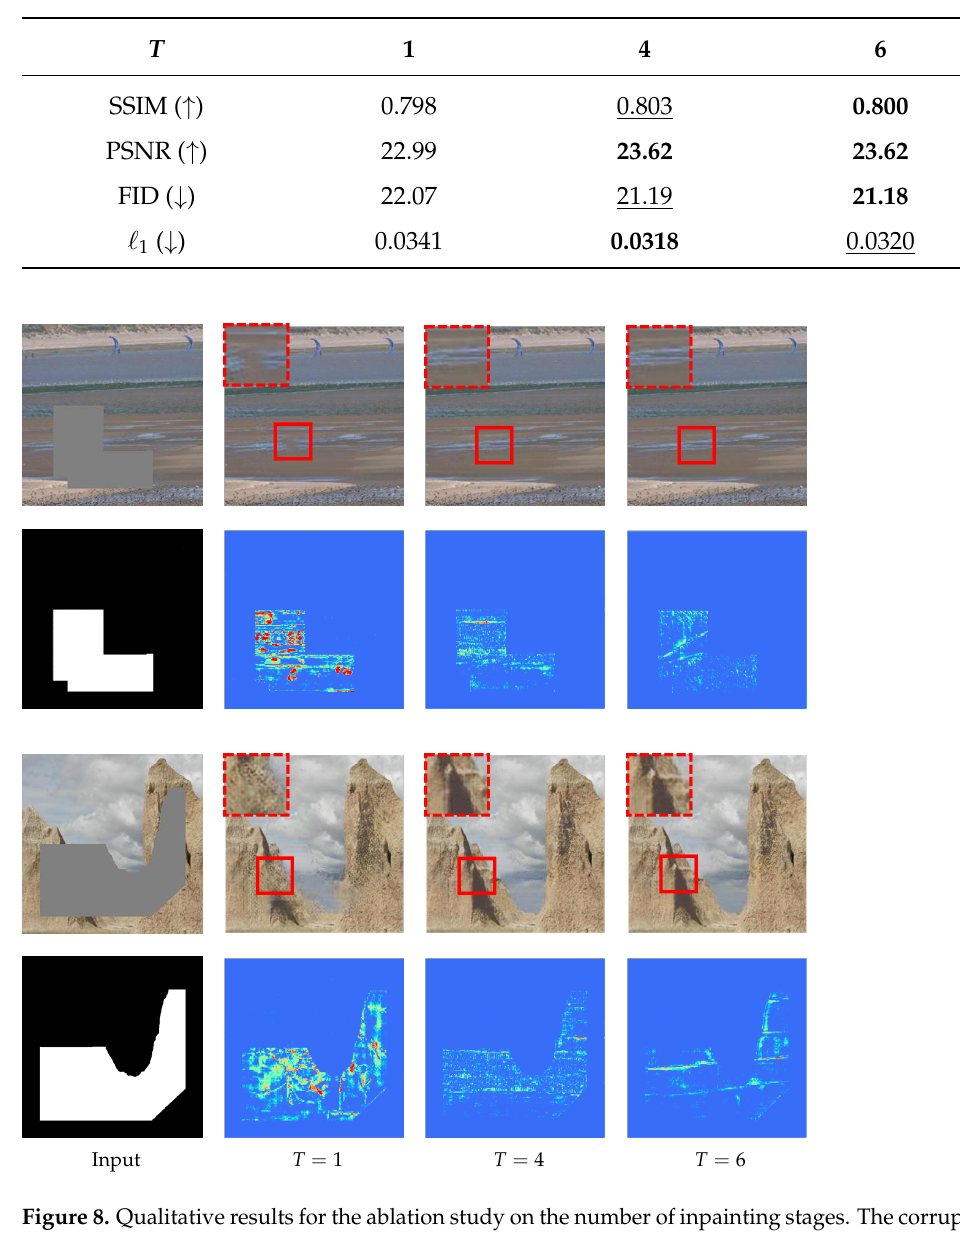
Figure 8. Qualitative results for the ablation study on the number of inpainting stages. The corruption rates, from top to bottom, are 23.1% and 33.7%,